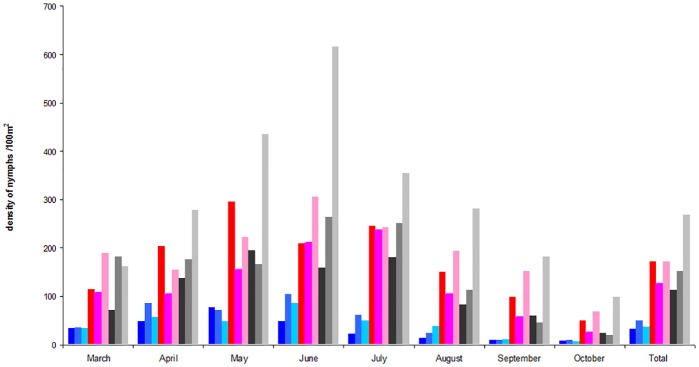
Density of I. ricinus nymphs in the five plots with chipmunks (α), one with little chipmunk (β) and two plots without chipmunk (γ) from the forest of Sénart in 2008, 2009 and 2011.α plots in 2008 (dark blue square), α plots in 2009 (cobalt blue), α plots in 2011 (aquamarine square); β plots in 2008 (red square), β plots in 2009 (fuchsia square), β plots in 2011 (pink square); γ plots in 2008 (black square), γ plots in 2009 (grey square), γ plots in 2011 (light grey square).